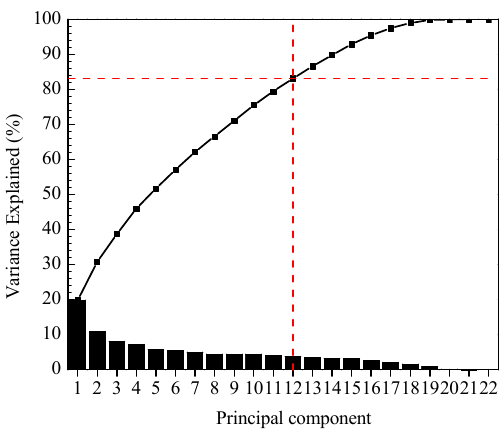
Figure 4. Principal component variance percent explained for fault 4.